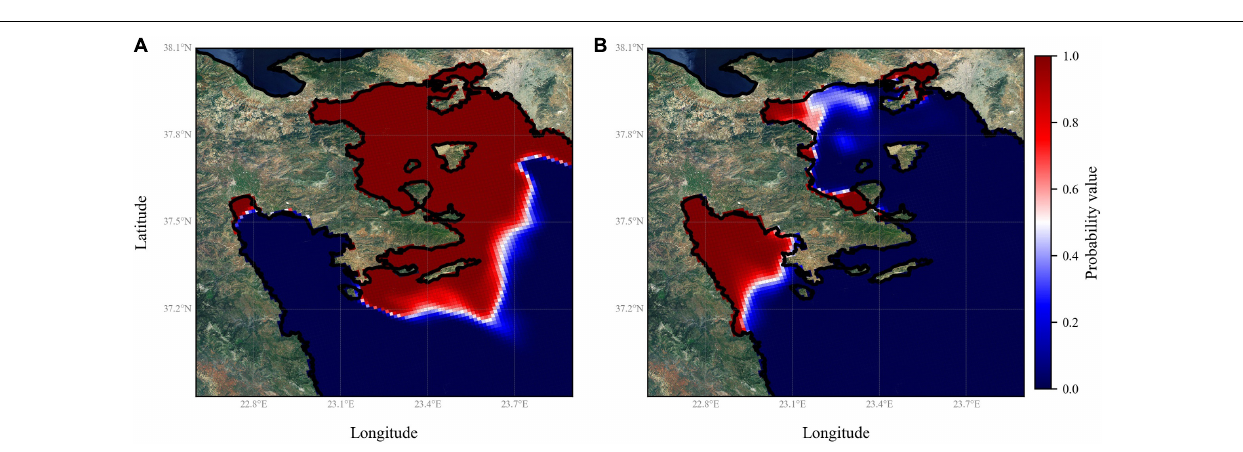
FIGURE 8 | Spatial maps of probability of (A) non-exceedance of 15 ◦ C – March 2017 (B) exceedance of 26 ◦ C – August